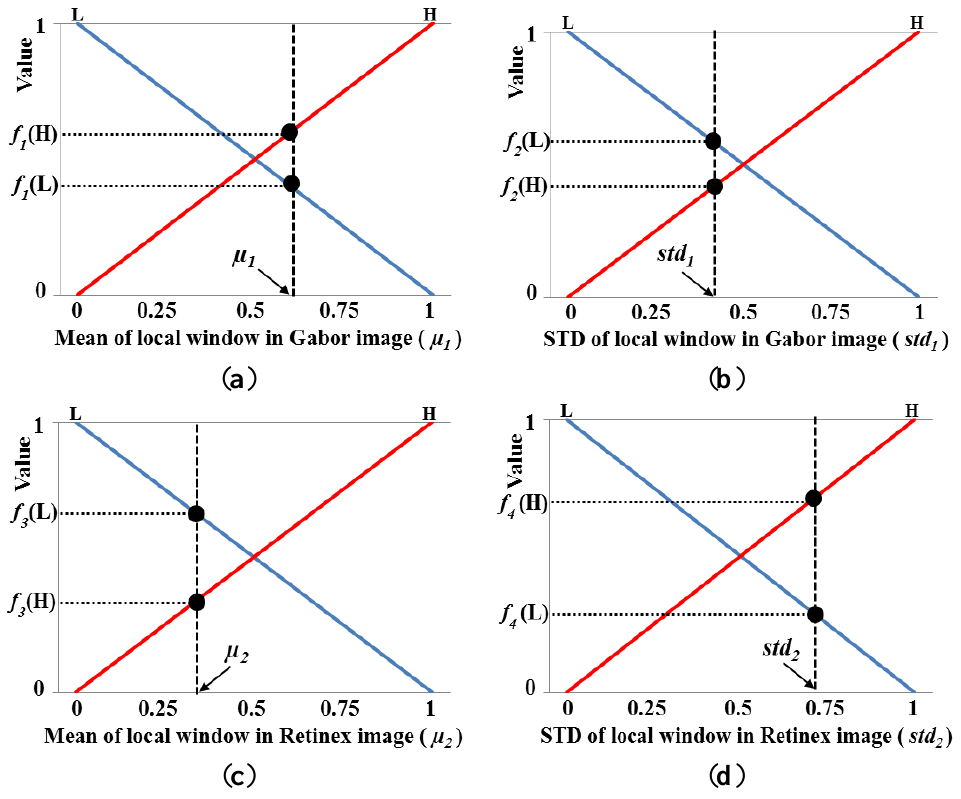
Figure 13. Illustrations showing the linear membership outputs based on four input values: